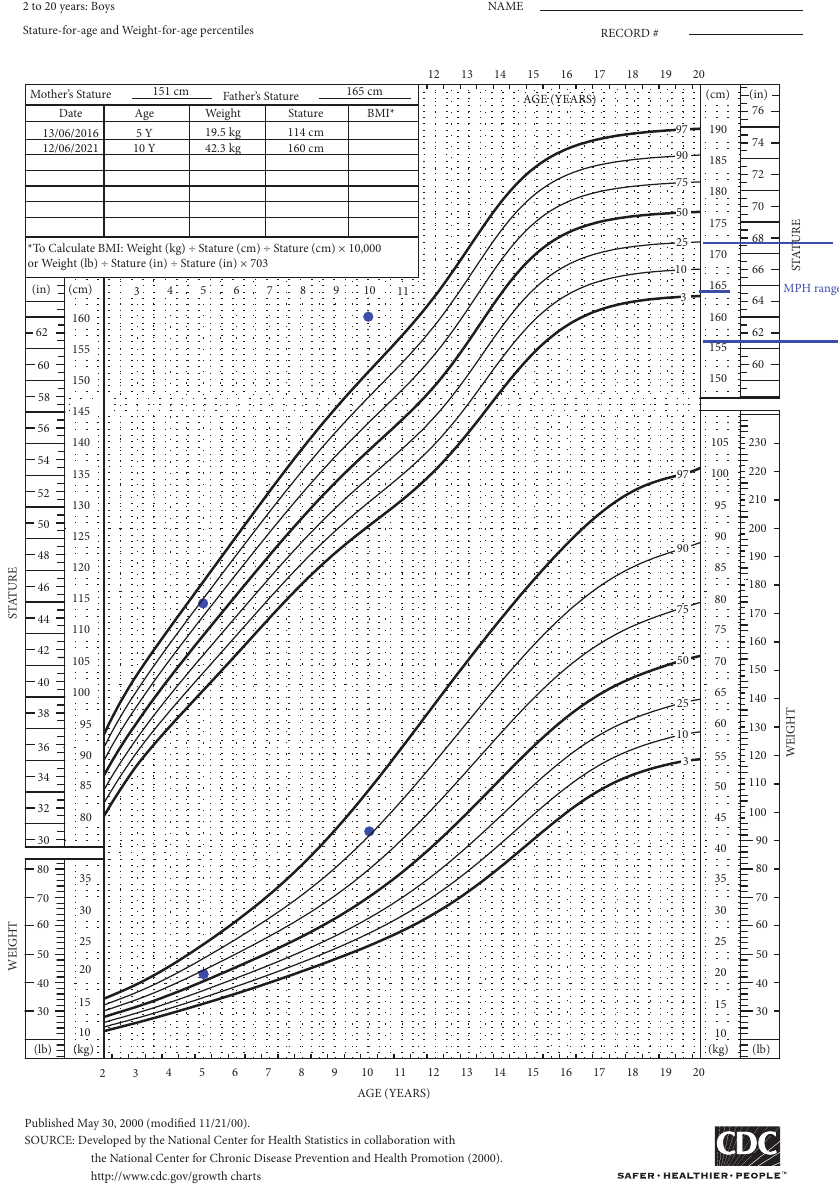
Figure 1: Growth chart of the index